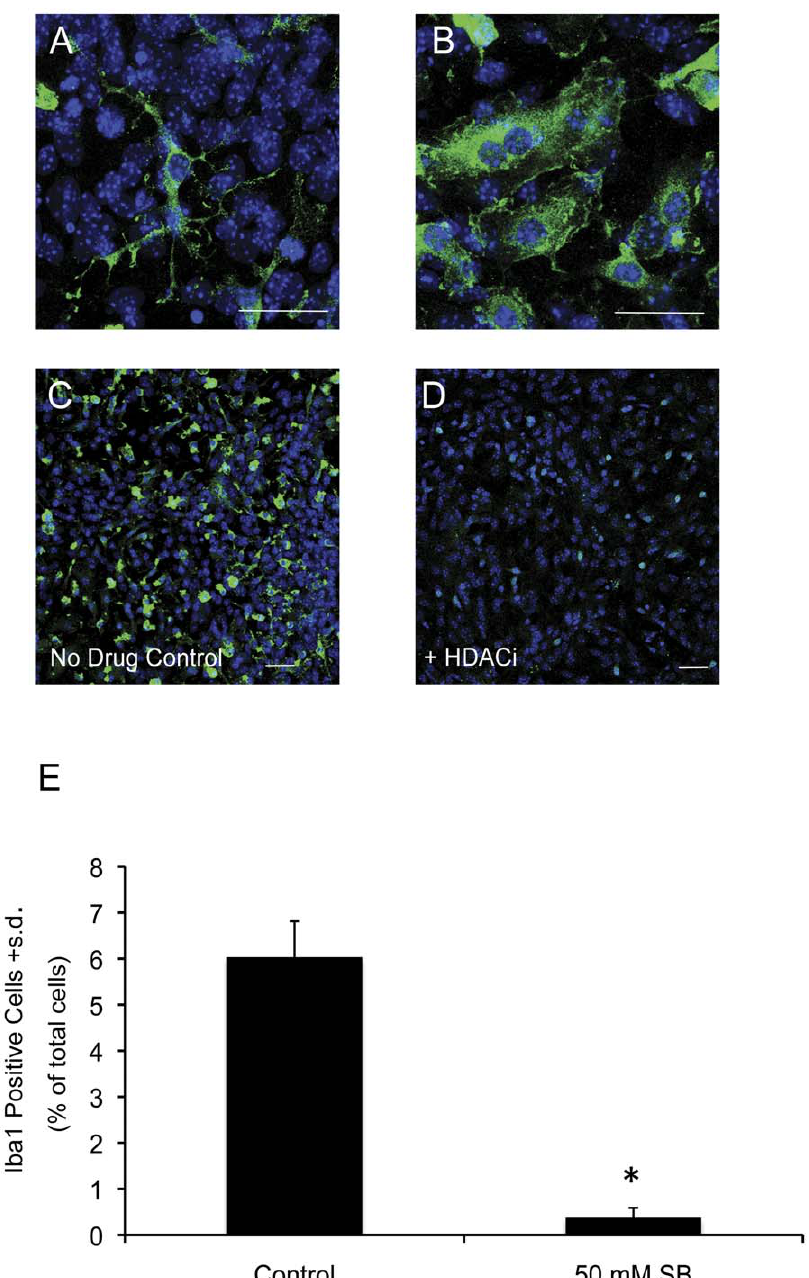
Figure 6. Effects of HDACi treatment on microglia in midbrain cultures. ( A) Iba1 positive microglial cell displaying a ramified morphology. (B) Iba1 positive amoeboid microglia. (C) Iba1 positive cells in an untreated, control midbrain culture. (D) Treatment with 50 mM SB for 48 hours significantly reduces the number of Iba1 positive cells in midbrain cultures. (E) Quantification of the decrease in Iba1 positive cells as a result of HDACi treatment. Bars represent the mean + s.d. (n=4). Asterisk (*) indicates that SB only treatment group is significantly different (p , 0.05) from the control treated group as determined by an unpaired Student’s t-test. Scale bars=50 m M. Blue= DAPI positive nuclei, green=Iba1.